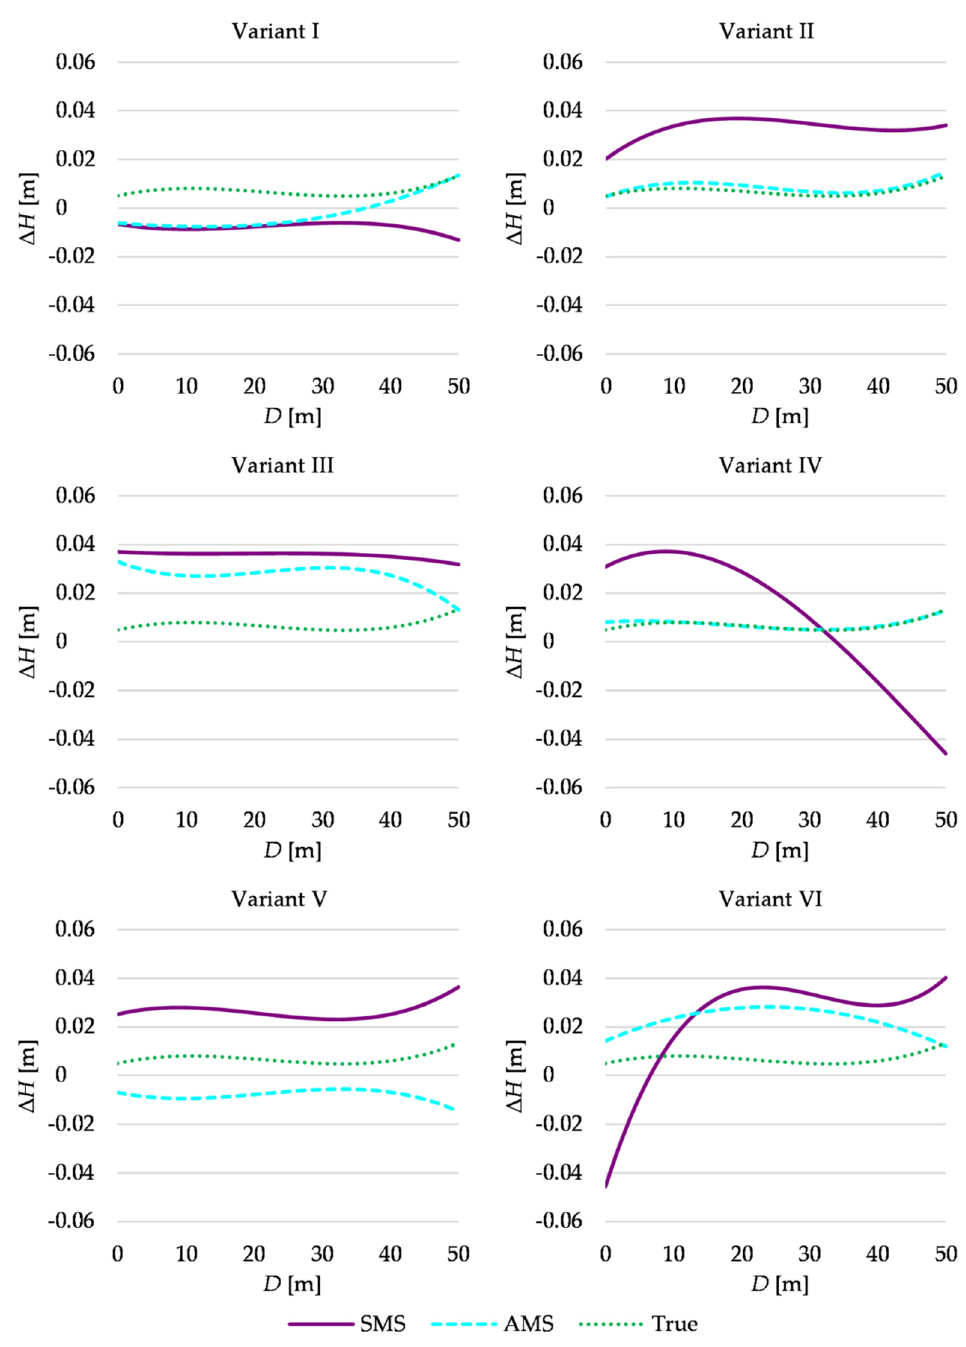
Figure 4. Estimated vertical terrain displacement (from the combined observation set) for different variants.